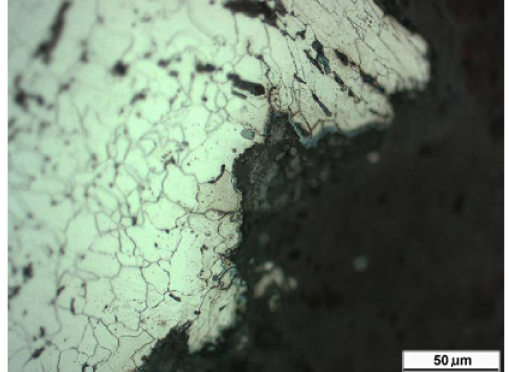
Figure 14. Damaged welded sample after